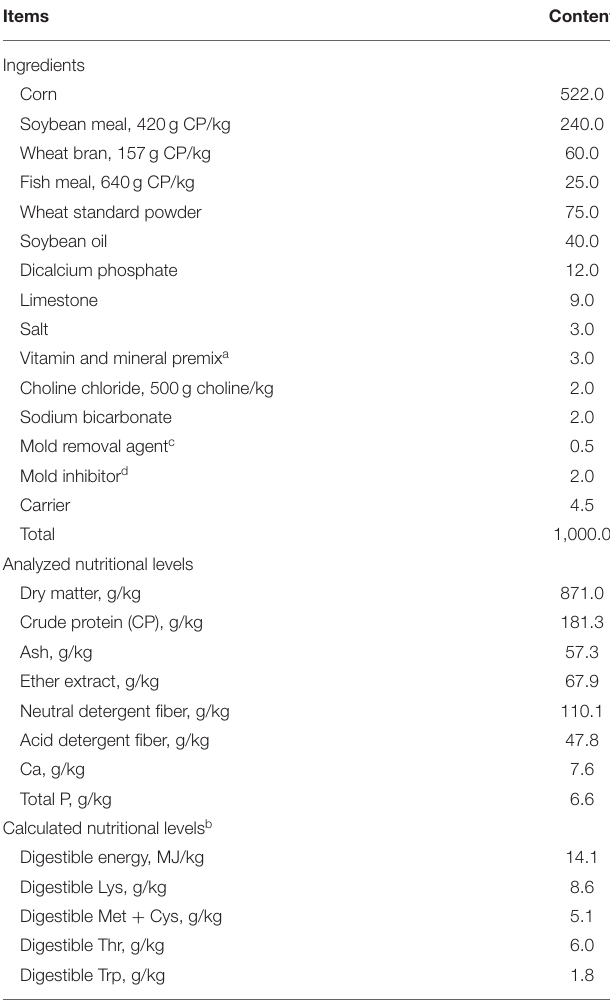
TABLE 1 | Ingredient composition and nutritional levels of the basic diet (g/kg, as-fed) basis).